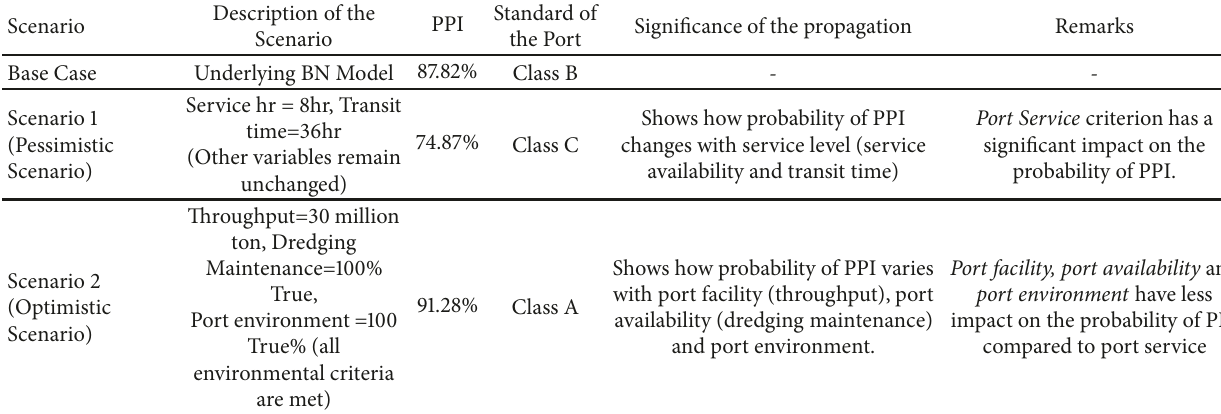
Table 13: Summary of propagation